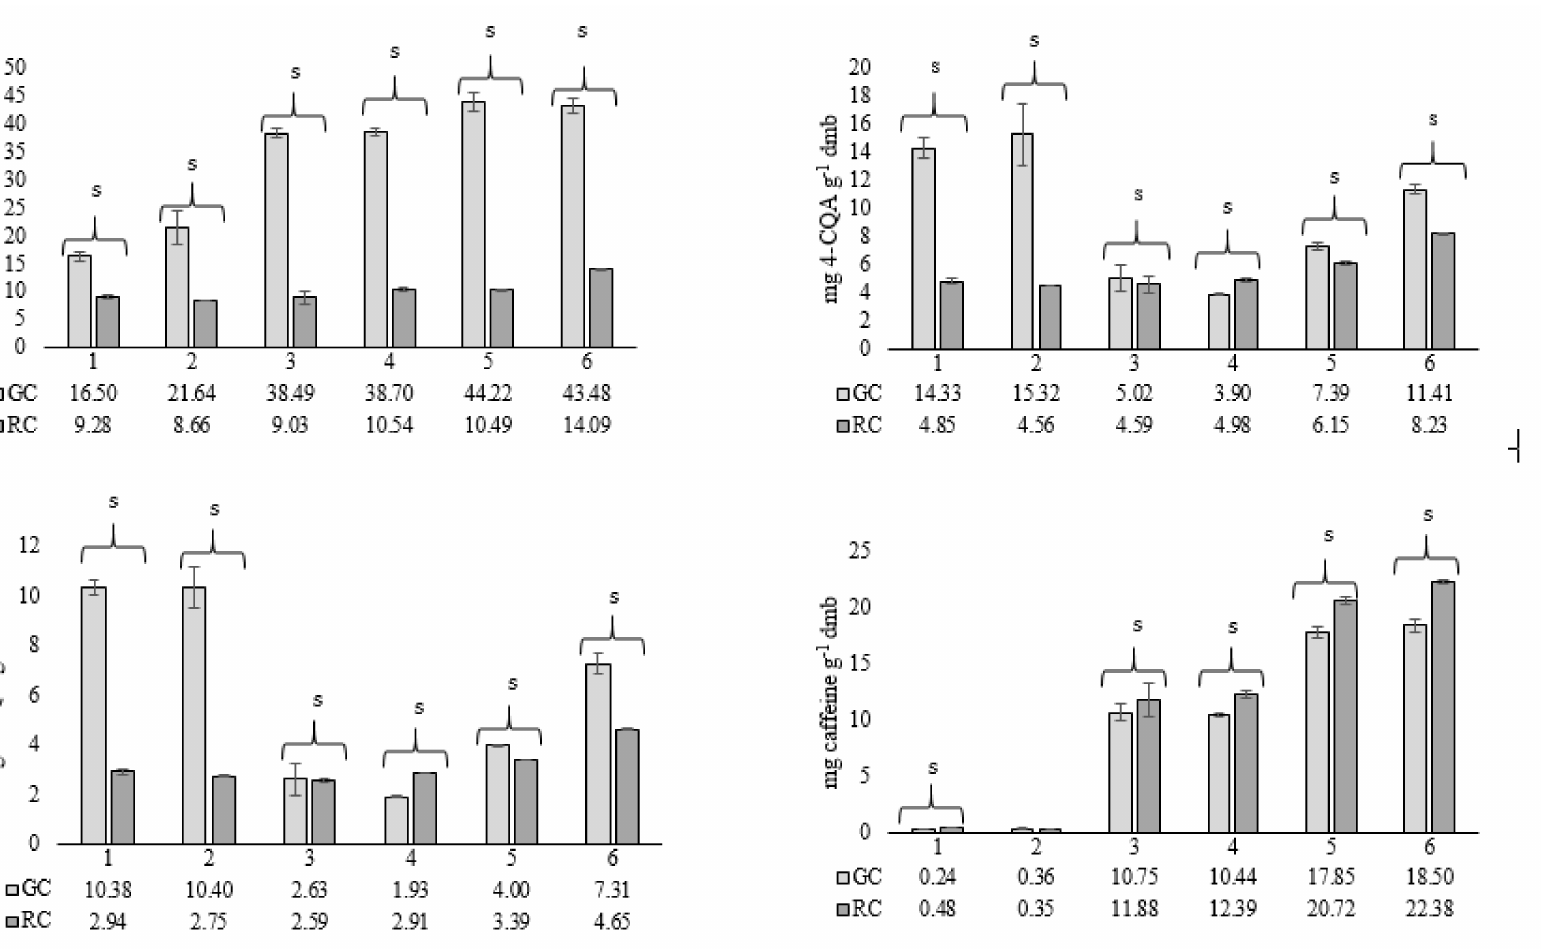
Figure 2. Content of individual phenolic compounds (3-CQA, 4-CQA and 5-CQA) and caffeine in green (GC) and roasted (RC) coffee beans. s—change in investigated parameter after roasting is significant ( p < 0.05), determined by single-factor